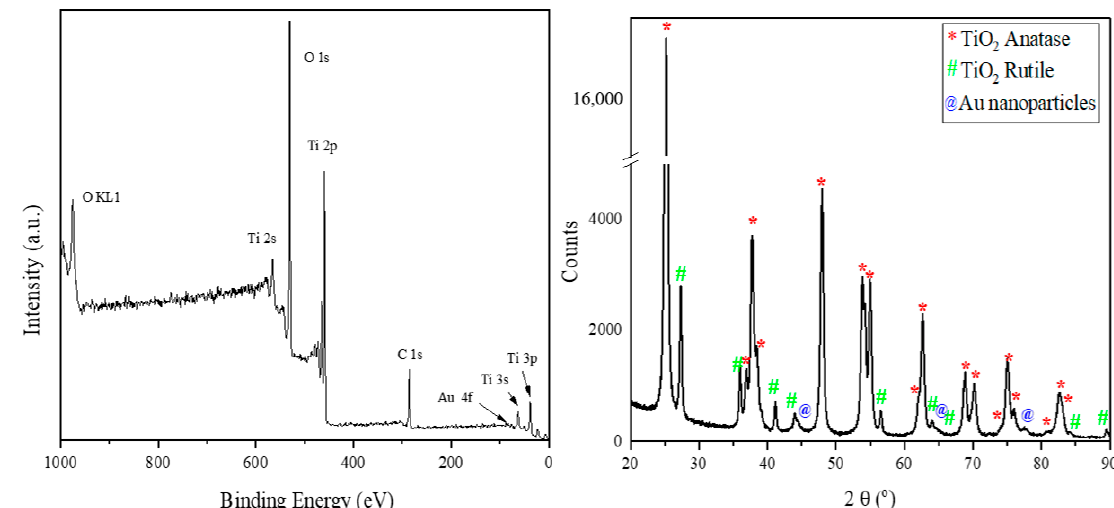
Figure 6. XPS and XRD analyses of the synthesised material.